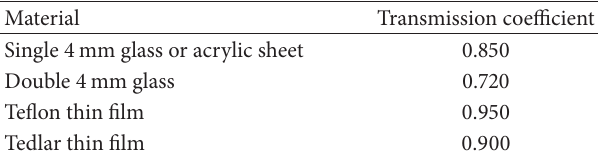
Table 3: Transmission coefficients of sample materials [5].